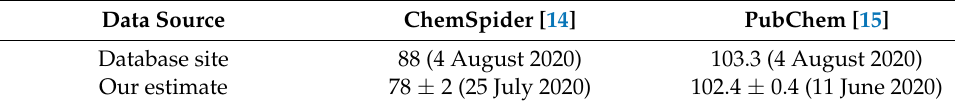
Table 1. The number of chemical compounds (millions) in the two